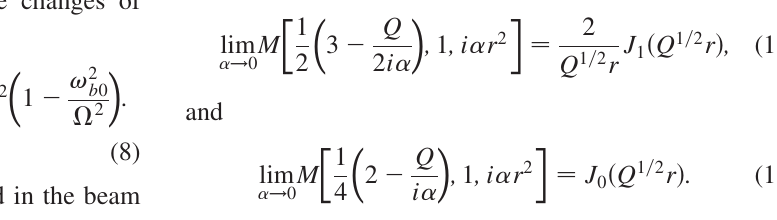
p ffiffiffiffiffiffiffiffiffiffiffiffiffiffiffi 1 (cid:4) (cid:5) 2 , and (cid:5) ¼ v 0 =c .